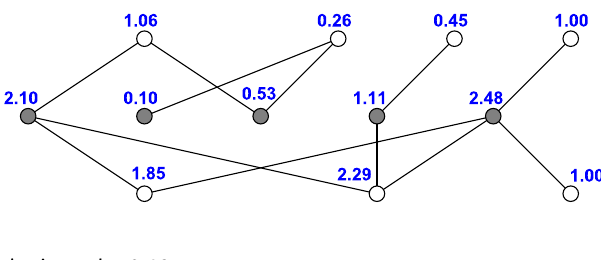
Figure 5: Eigenvector for simple eigenvalue 2.48